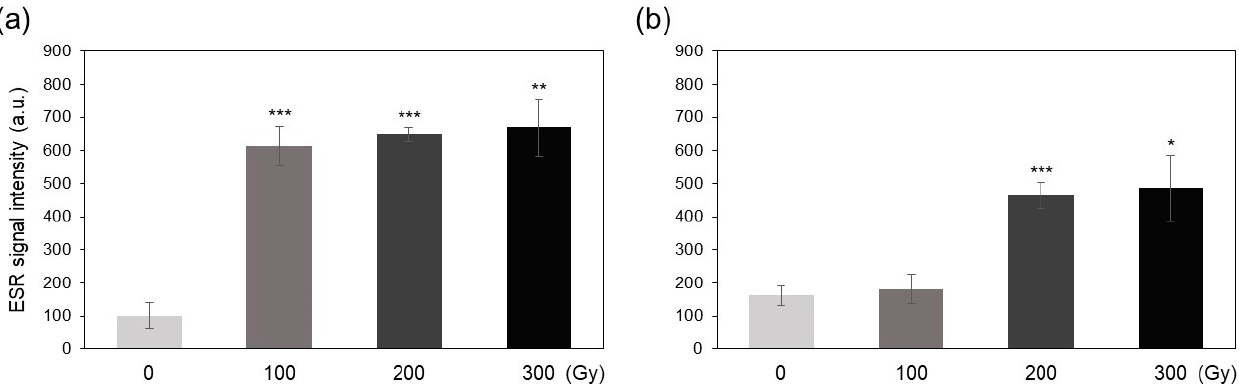
Figure 1. DNA damage induced by acute and chronic gamma irradiation in rice plants. ( a ) Acute irradiation treatments; ( b ) chronic irradiation treatments. Data represent mean ± standard deviation (SD). Asterisks indicate significant differences between control (0 Gy) and other treatments (* p < 0.05, *** p < 0.001).